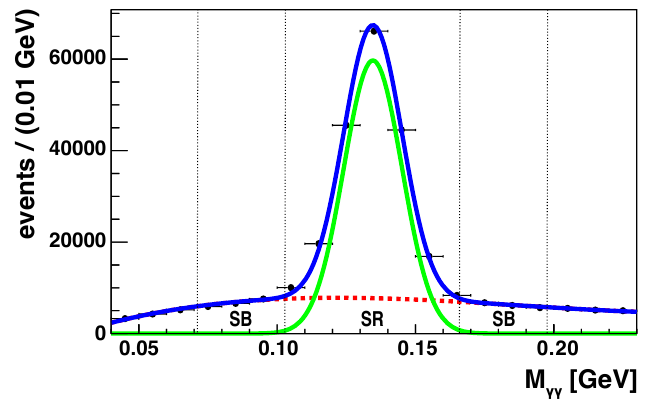
Figure 2 . The two-photon invariant-mass distribution in the region of the π 0 mass for the overall data sample. The sum (blue line) of a Gaussian for the π 0 signal (green line) and a third-order Chebyshev polynomial for the combinatorial background (red dashed curve) are fit to data. The signal range used in the analysis, indicated as “SR”, spans a ± 3 σ region around the π 0 peak position. Events for the background subtraction are selected from the sidebands denoted by “SB”. The signal-region and sideband boundaries are indicated by vertical dotted